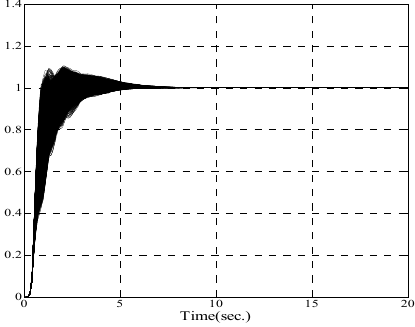
Fig.7. Closed-loop step responses of Monte-Carlo